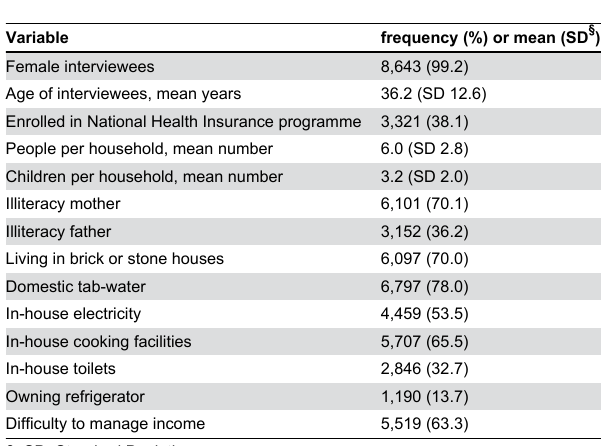
Table 1. Characteristics of the interviewees (N = 8,715), Asante Akim North District, Ghana,